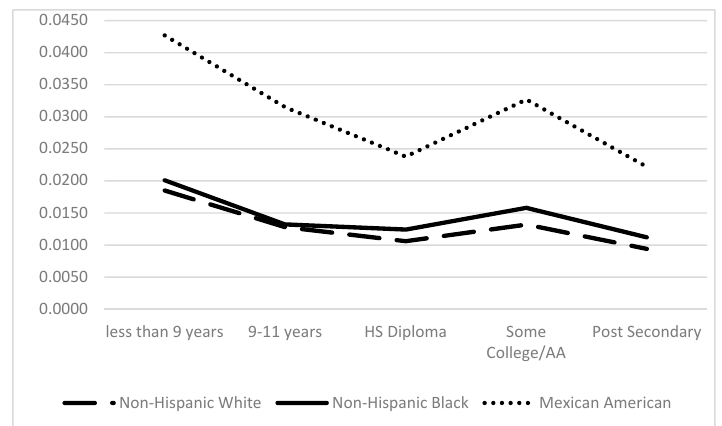
Figure 1. Predicted probability of intermediate C-reactive protein by education and race/ethnicity. Note: Differences across groups statistically significant at the p < 0.001 level. Model controls for age, sex, income, education, smokers, heavy drinkers, HBP, HWC, diabetes, statin use and interactions.